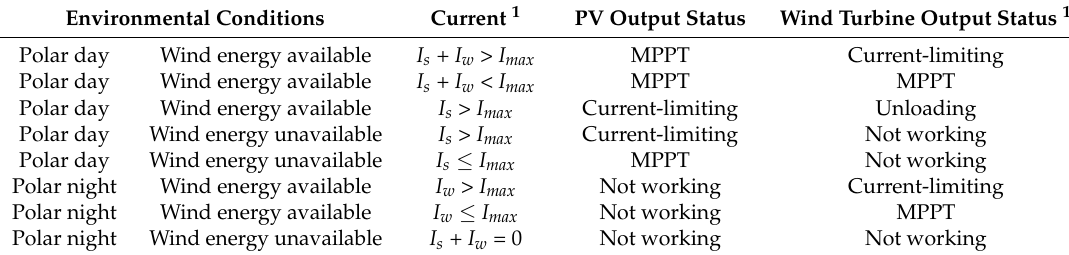
Table 5. The charging strategy of the hybrid wind-solar system ( T a > T c ). Table 6. The charging strategy of the hybrid wind-solar system ( T a < T c